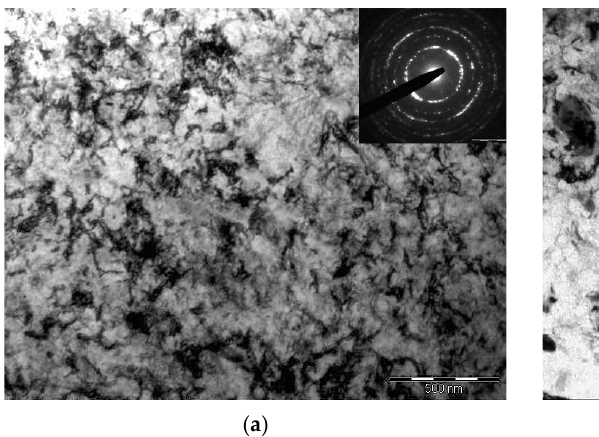
Figure 1. Bright-field transmission electron microscopy (TEM) images of Grade 91 microstructure after quenching and tempering at: ( a ) 500 °C; ( b ) 800